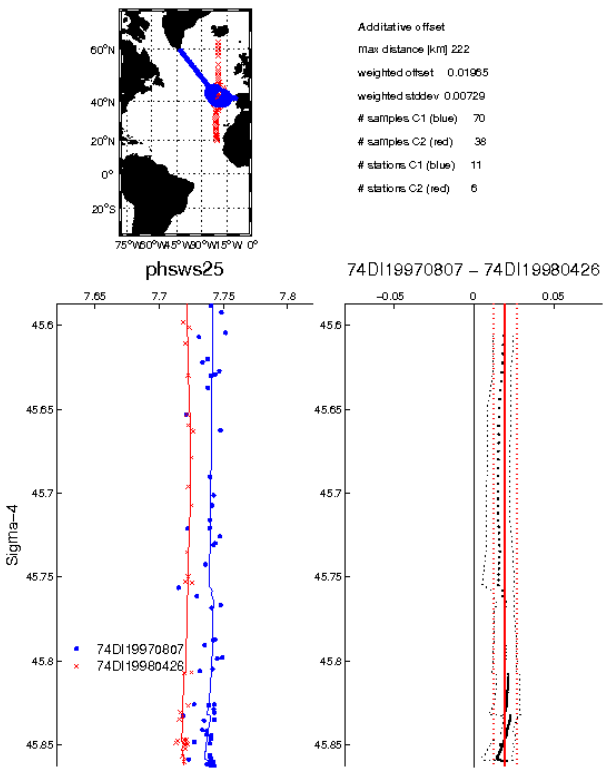
Figure 2. Crossover made with Running-Cluster